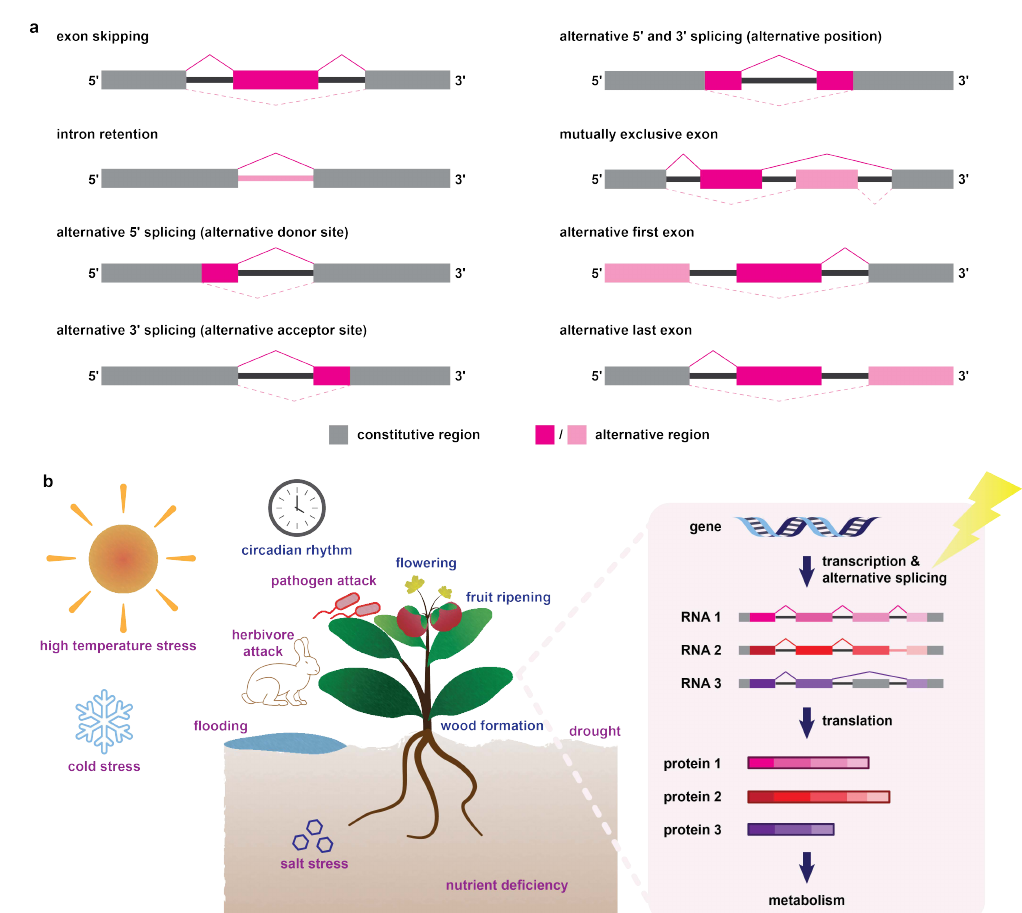
Figure 2. Alternative splicing and its regulation on metabolism in plants during stress responses and development. ( a ) Common types of alternative splicing events in plants. Boxes: exons; horizontal lines: introns; ( b ) regulation of alternative splicing by stresses and developmental stages. Stresses that regulate alternative splicing are indicated in purple. Developmental stages that regulate alternative splicing are indicated in navy